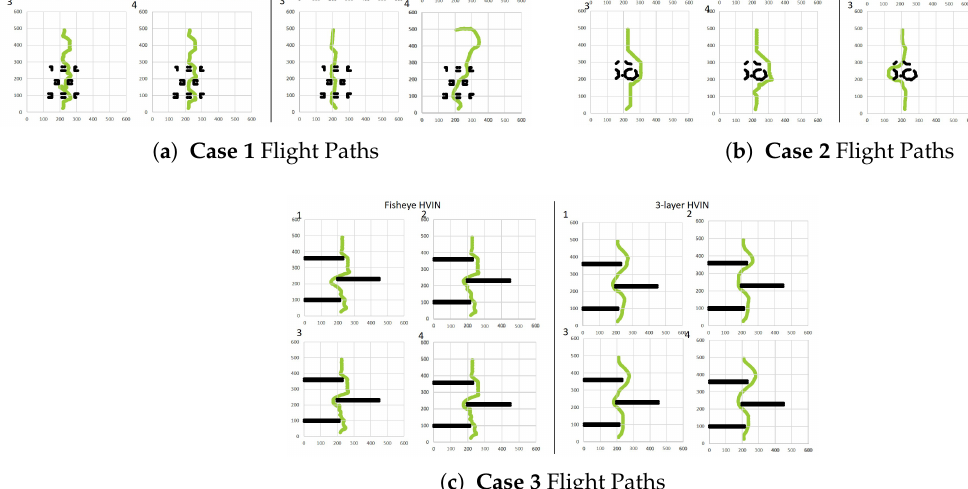
Figure 11. Simulation results.